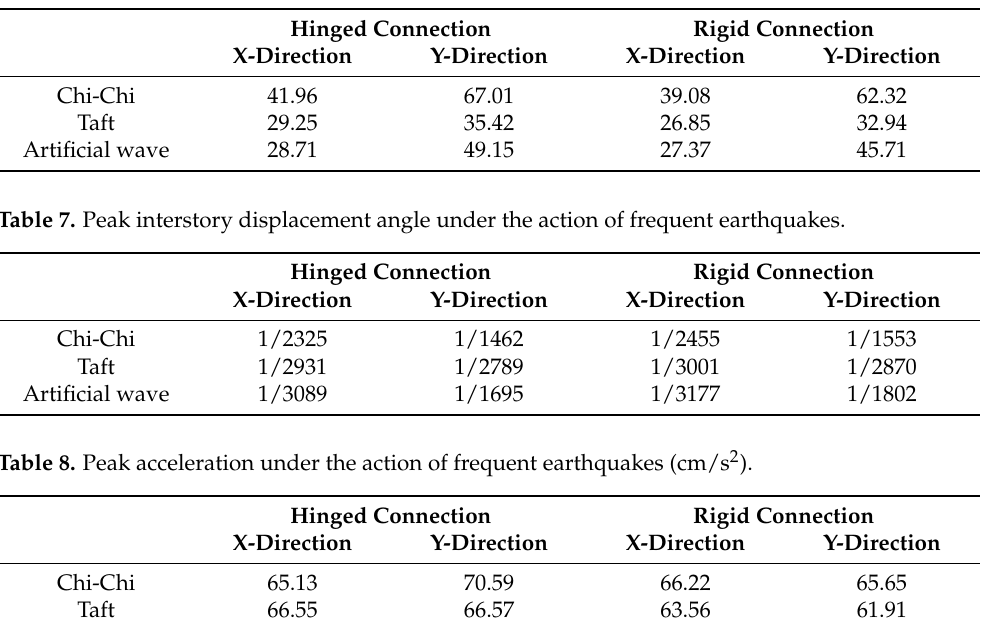
Table 6. Peak displacement under the action of frequent earthquakes (mm).